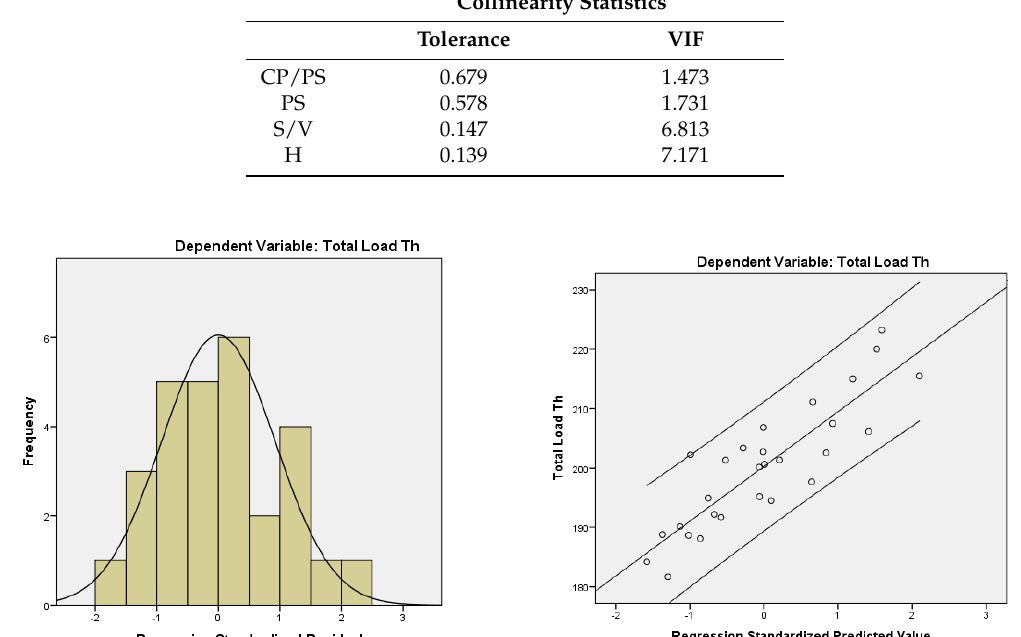
Table 19. Collinearity statistics for the four independent variables included in both regression models.